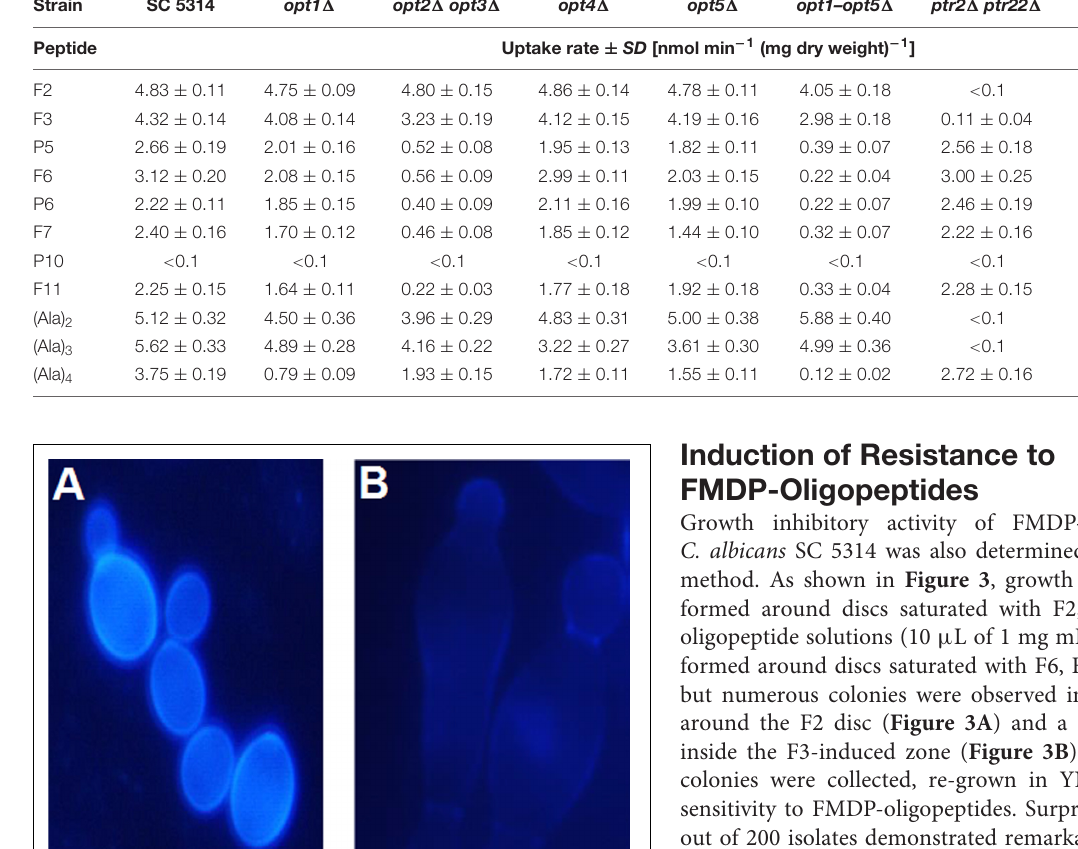
TABLE 7 | Initial uptake rates of FMDP-oligopeptides and model alanyl oligopeptides by C. albicans wild type cells and oligopeptide transporters-deficient mutants. Strain